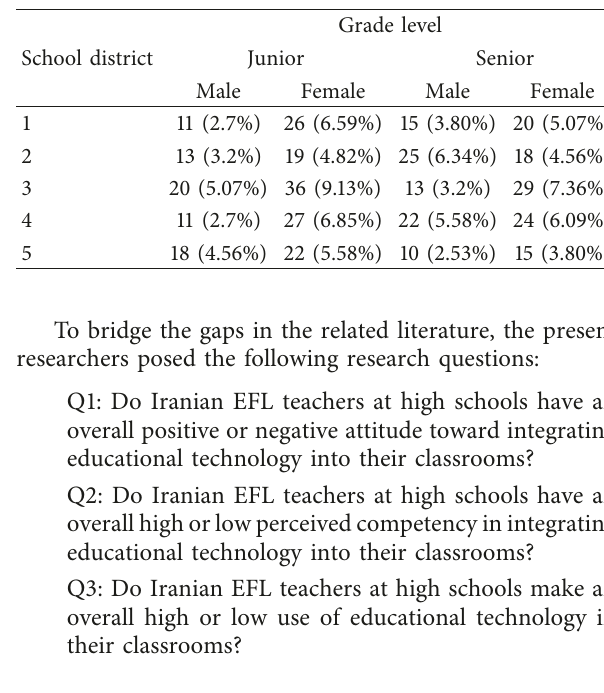
Table 1: The in-service EFL teachers in five school districts during the school year